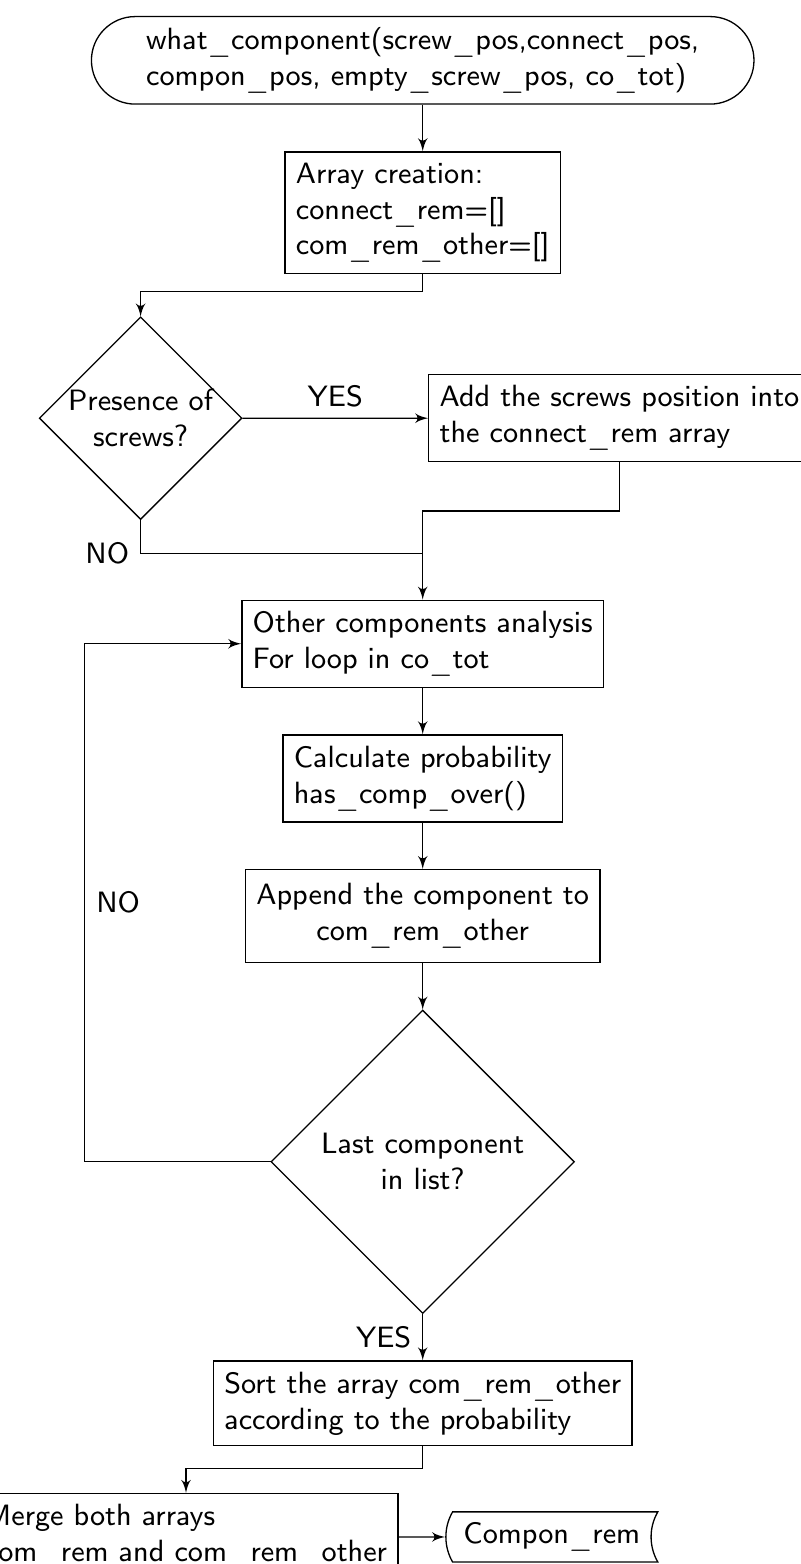
Figure 5. Function what_component flow chart